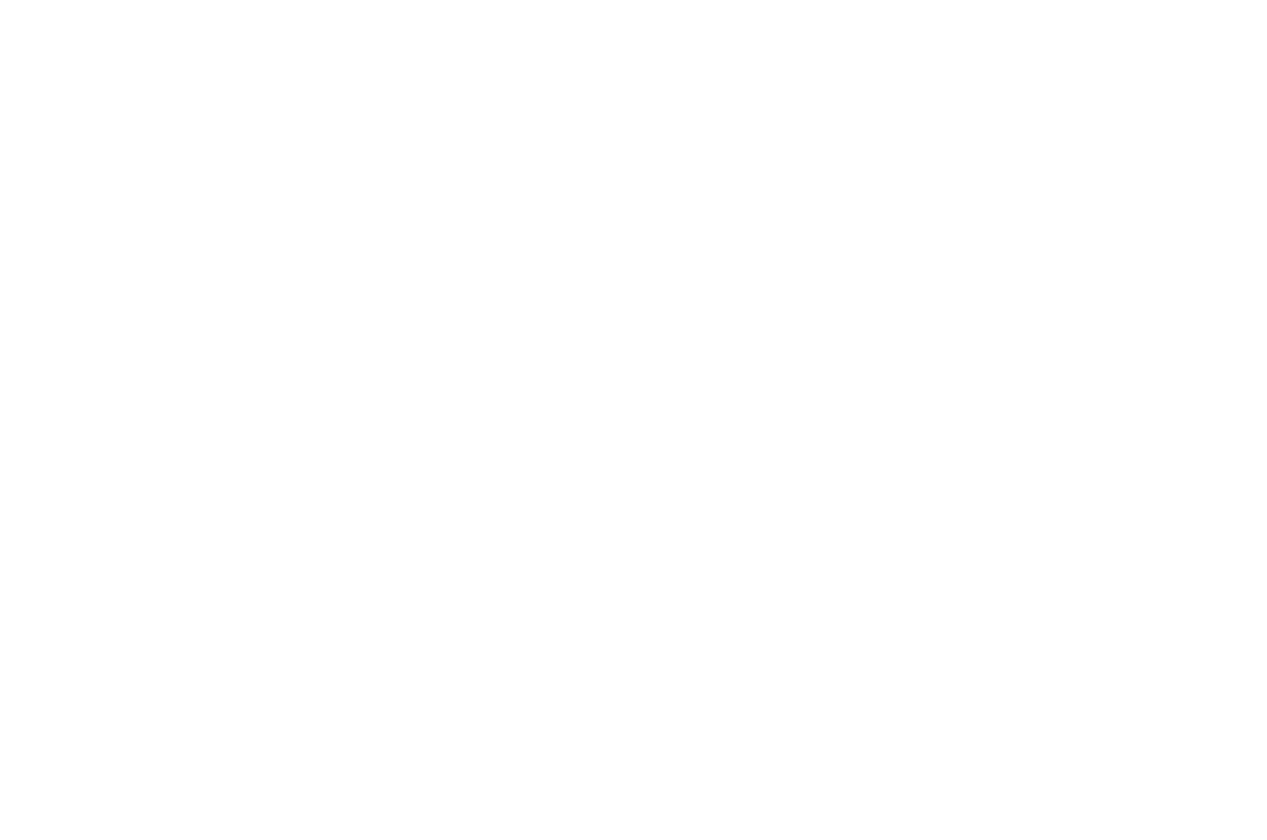
Frontiers in Pediatrics |